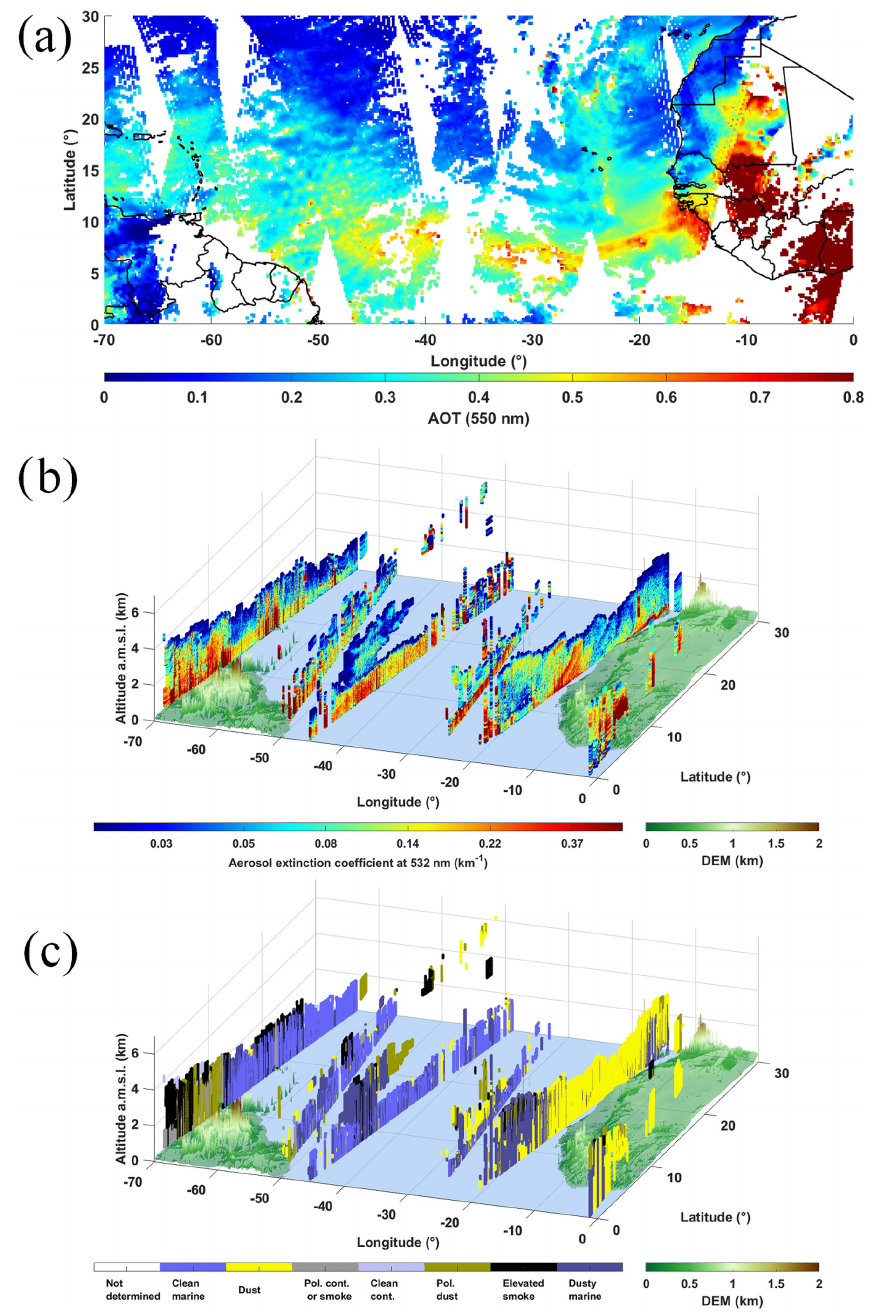
Figure 9. Same as Fig. 7 but on 11 February 2020.